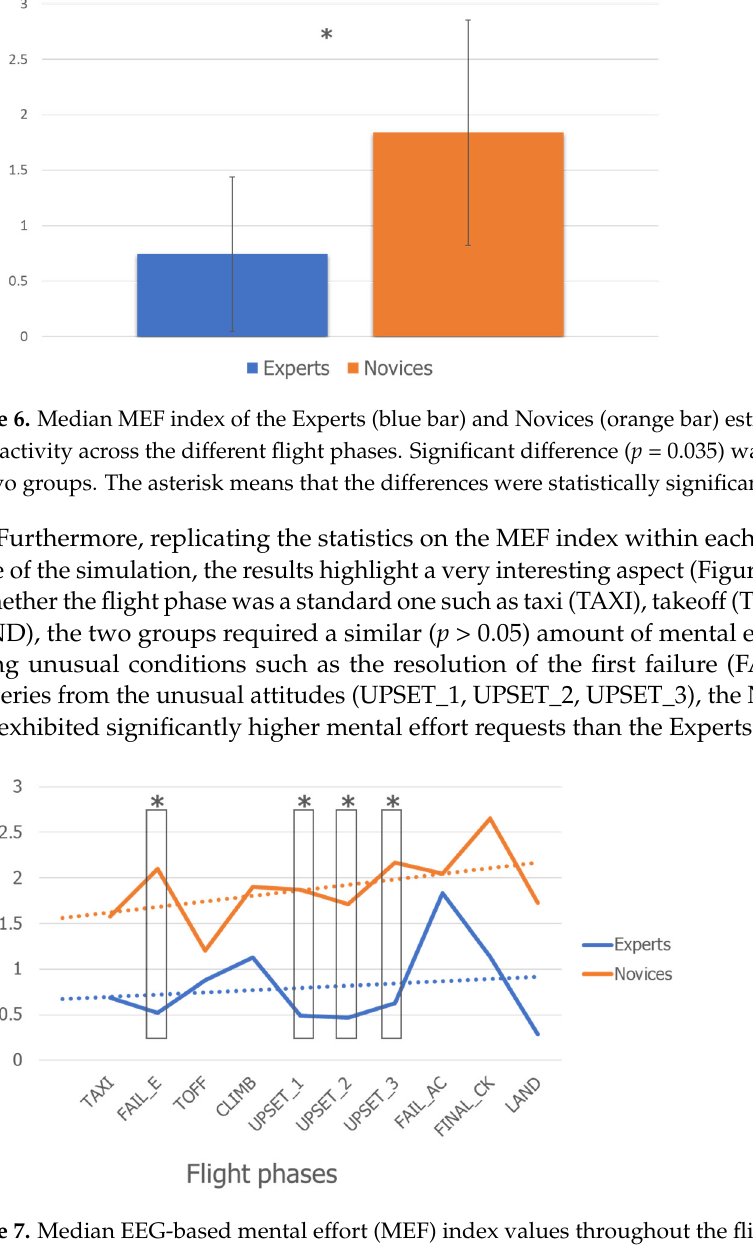
Figure 5. Median LF–HF values of the Experts (blue bar) and Novices (orange bar) across the entire flight simulation. No statistical difference ( p = 0.6) was found between the two groups.